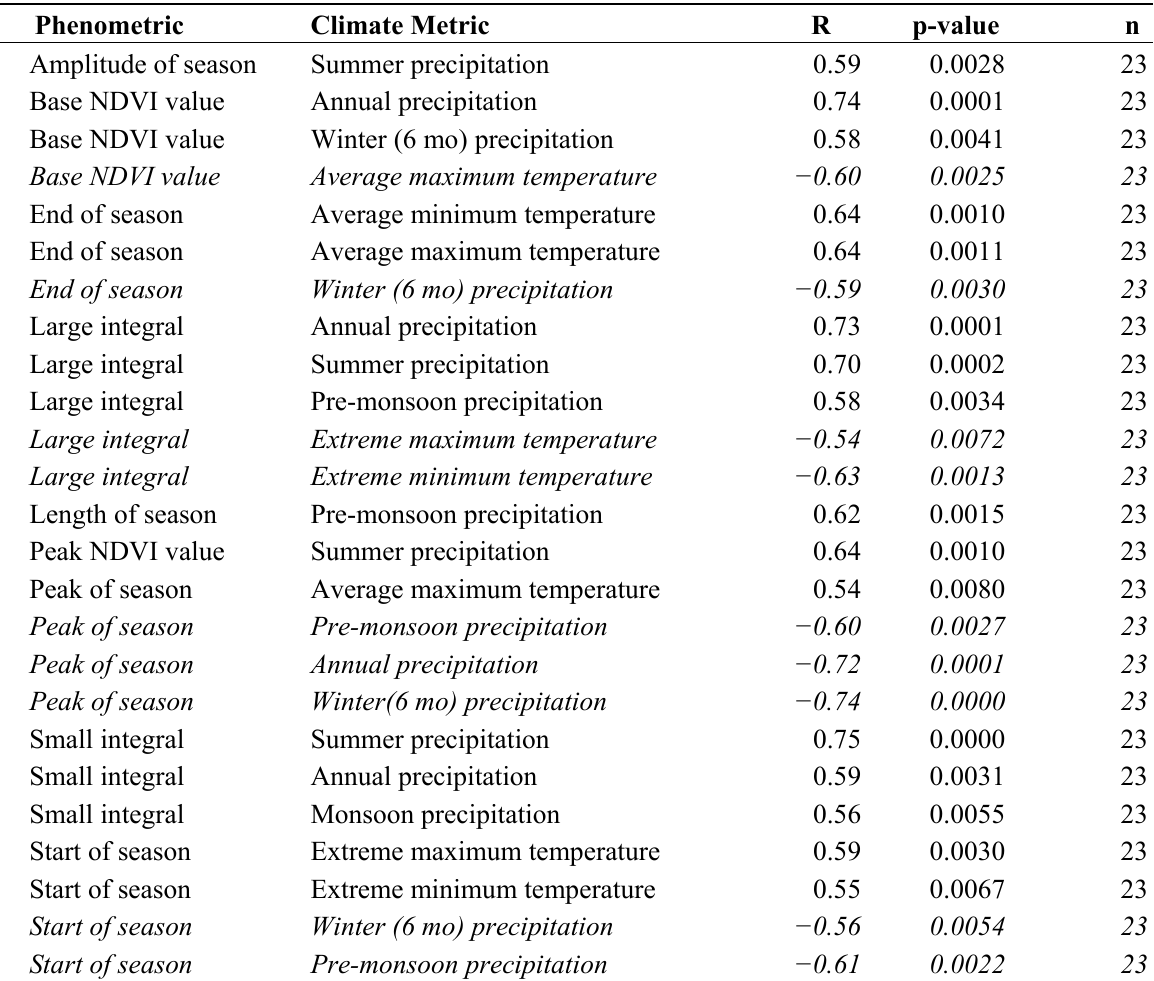
Table 4. Significant correlations (p ≤ 0.0081) between phenometrics and climate metrics for semi-desert grassland. Relationships that have negative R values are italicized. (Elevation ~1,357